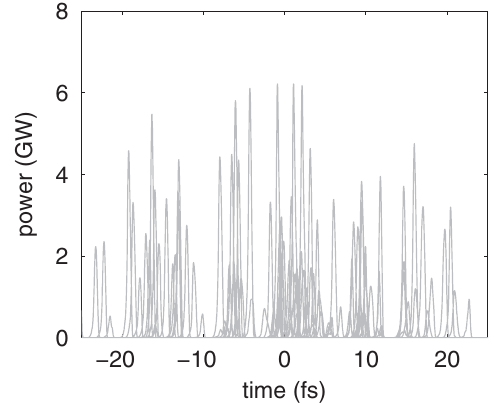
FIG. 16. Power at saturation for 100 different random seeds. Calculations are performed including realistic gun and linac